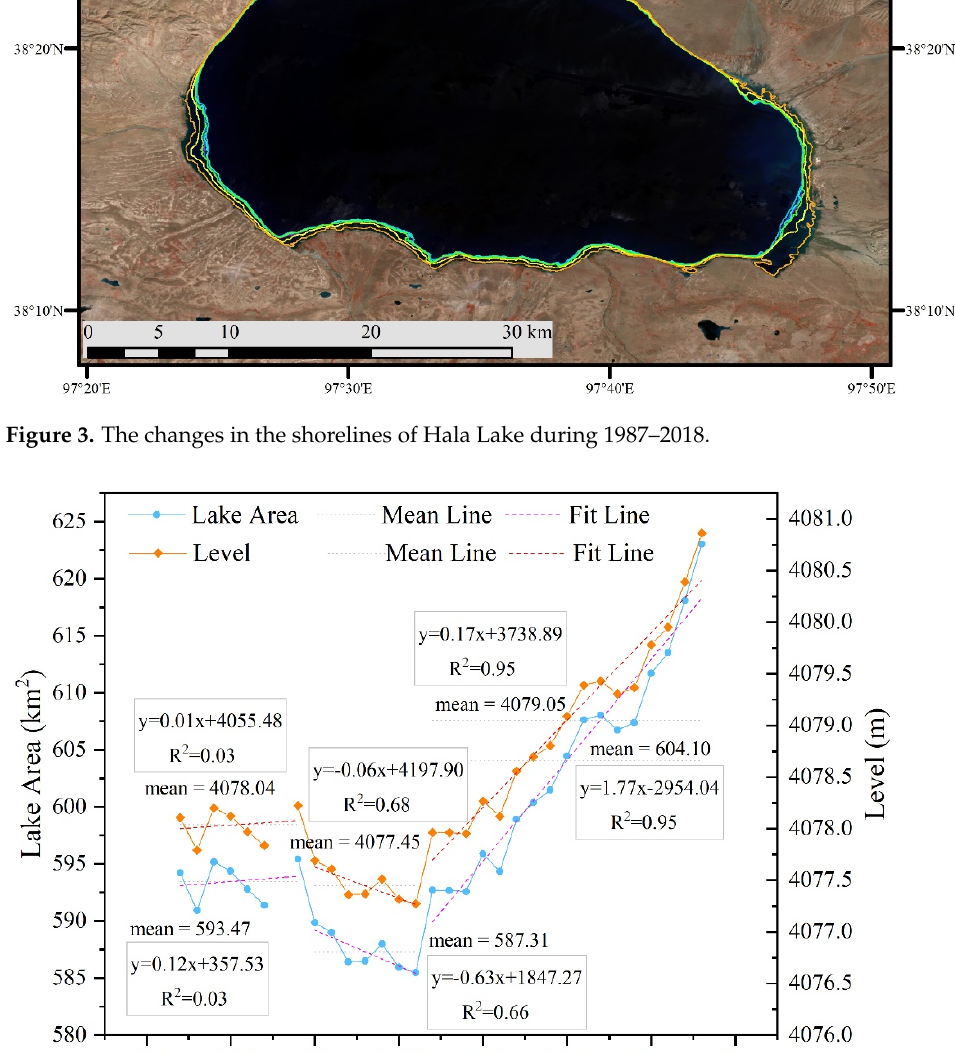
Figure 5. The storage change of Hala Lake during 1987–2018.